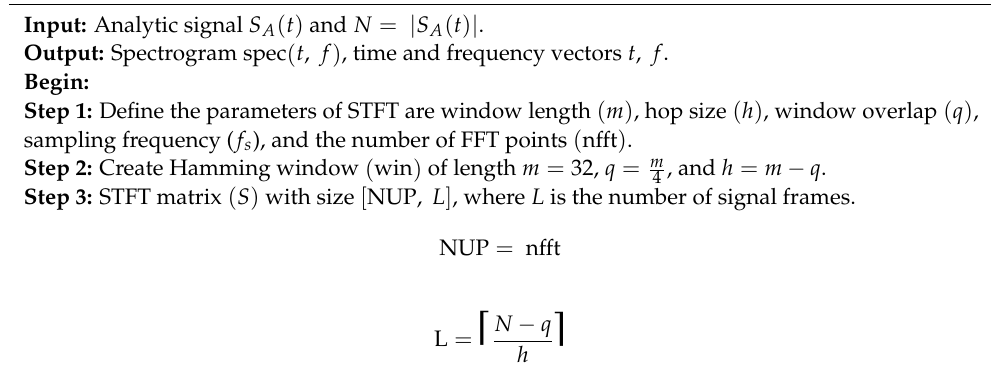
Algorithm A3: Spectrogram of Short-Time Fourier